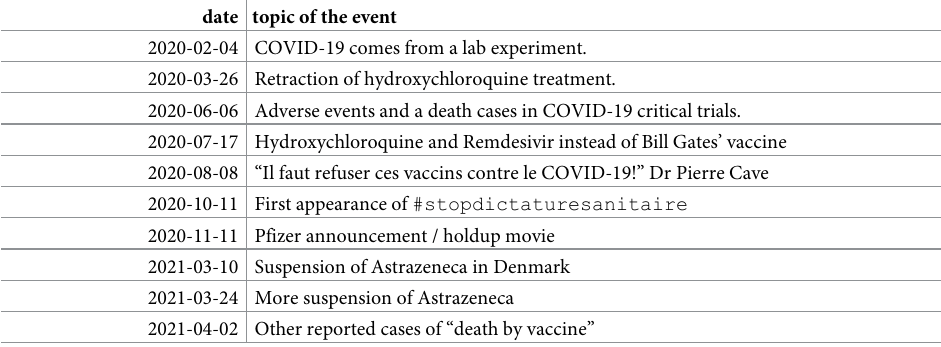
Table 1. Events detected. List of events that triggered a rapid growth of engagement within Twitter users. date topic of the